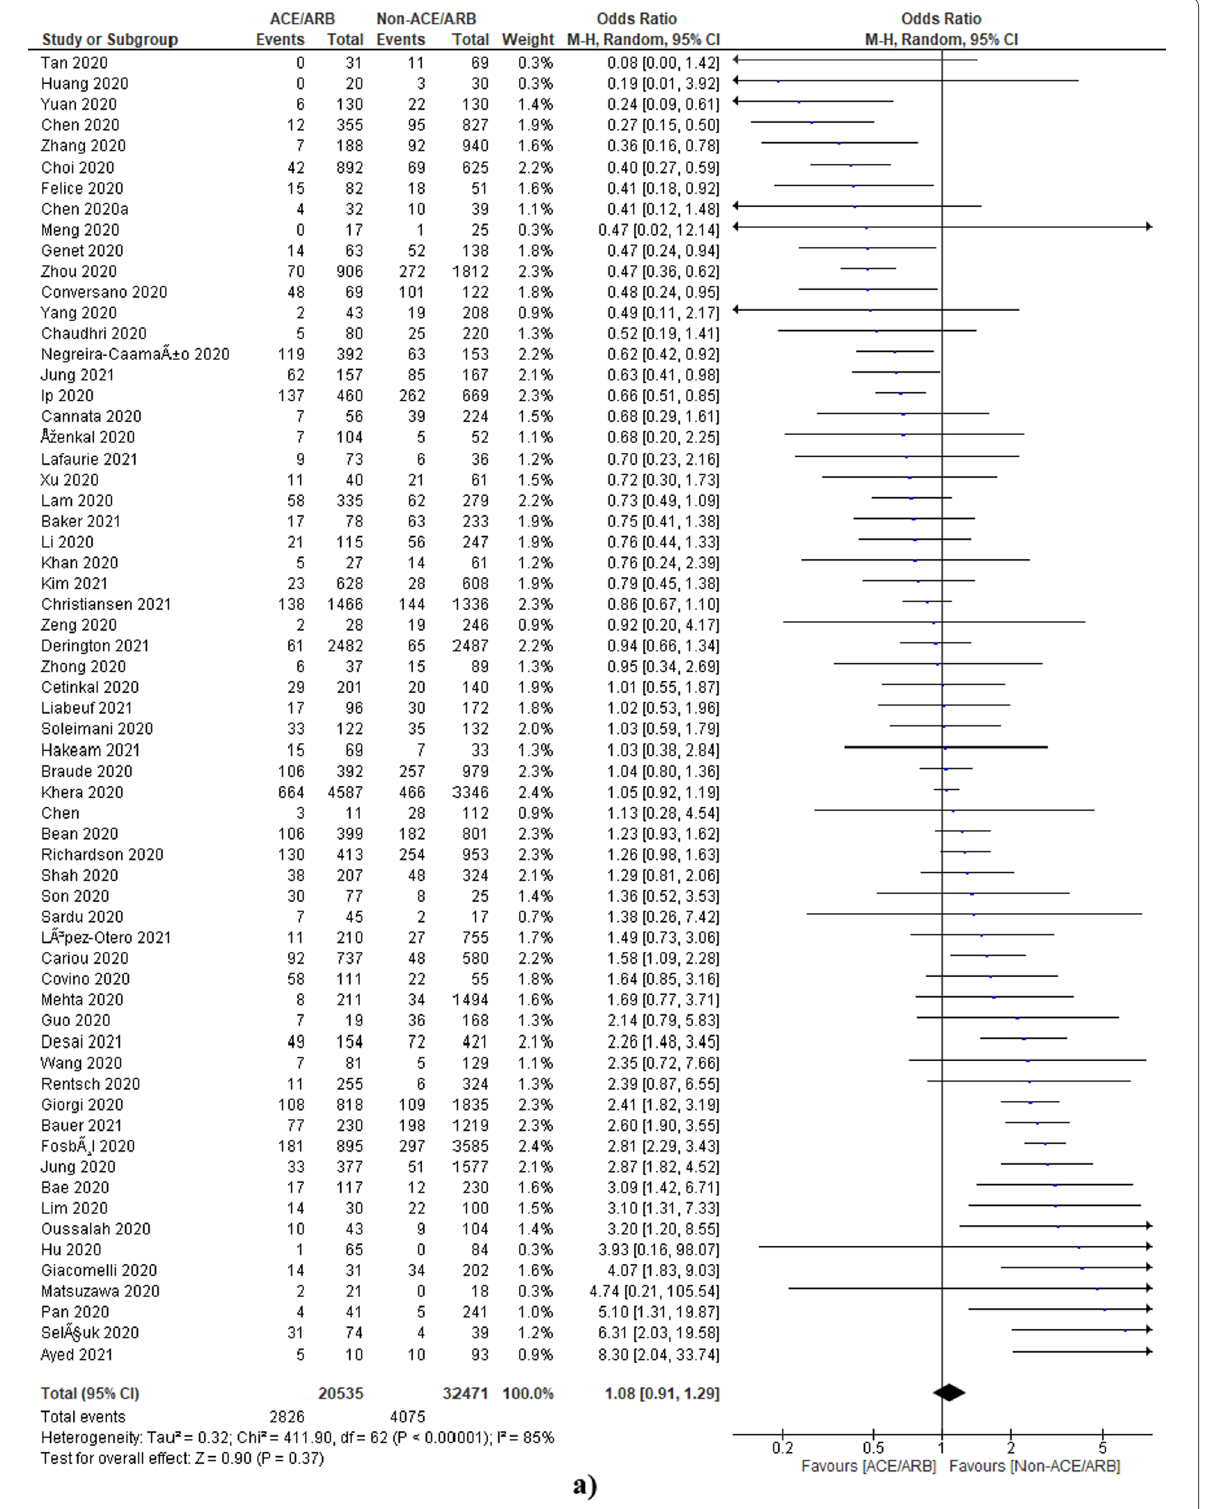
Fig. 8 Sensitivity analysis a forest plot of ACEi/ARB after exclusion of high sample size studies (Rosenthal 2020 [63], Rodilla 2020 [62], Rezel-Potts 2021 [60], Lee 2020 [48]) and low sample size study (Banerjee 2020 [20]). b Forest plot of ACEi after exclusion of high sample size studies (Fosbol 2020, Lee 2020) [8, 48] and low sample size study (Banerjee 2020) [20]. c Forest plot of ramipril after exclusion of high sample sizes (Braude 2020) [23] and low sample size (Banerjee 2020) [20]. d Forest plot of ARBs after exclusion of high sample size (Fosbol 2020, Lee 2020) [8,